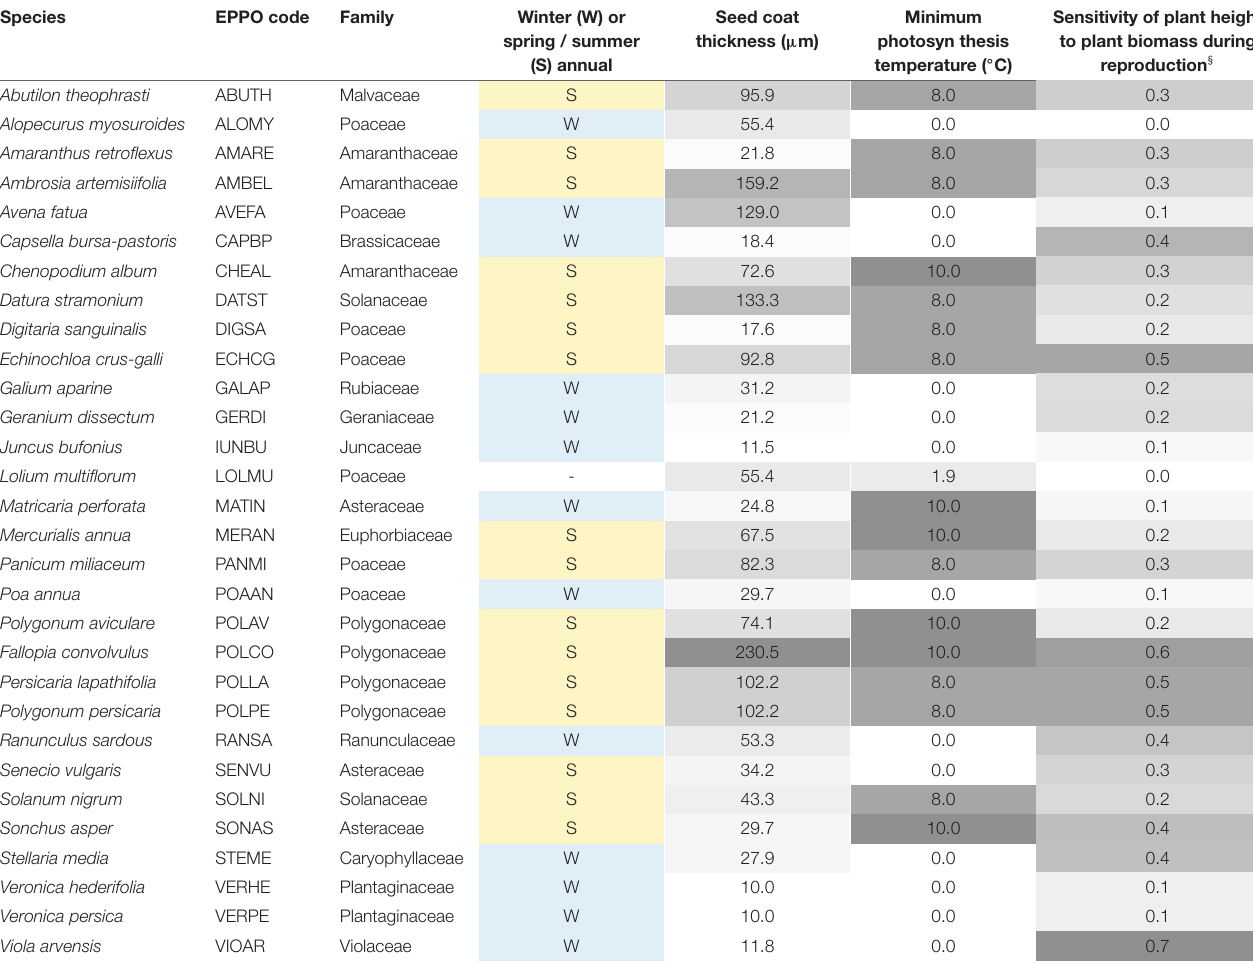
TABLE A1 | The 30 annual weed species included in F LOR S YS in the present simulation study with values for a few major traits identified with the RLQ and 4th-corner analyses of Figure 5 .